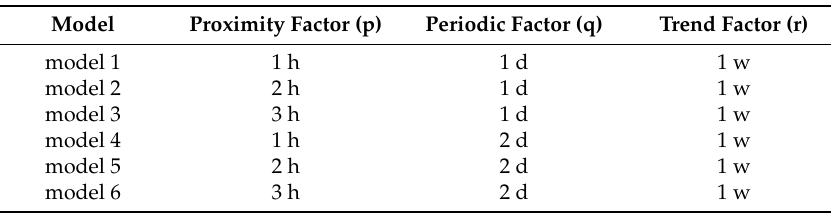
Table 3. Six models with di ff erent inputs.